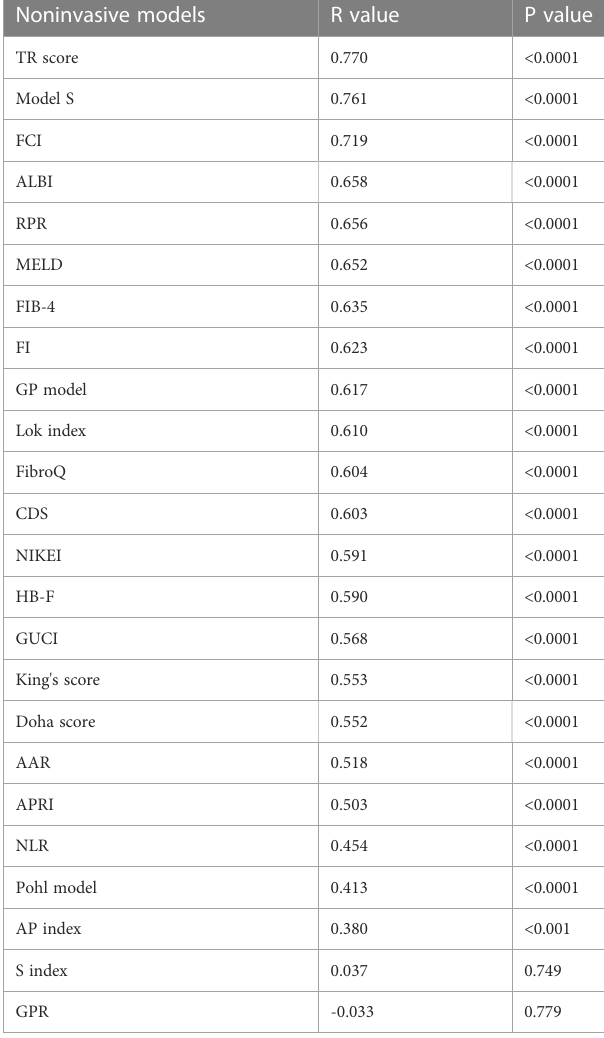
TABLE 4 Correlation analysis between 24 models and the histological stage of PBC in the model group. Noninvasive